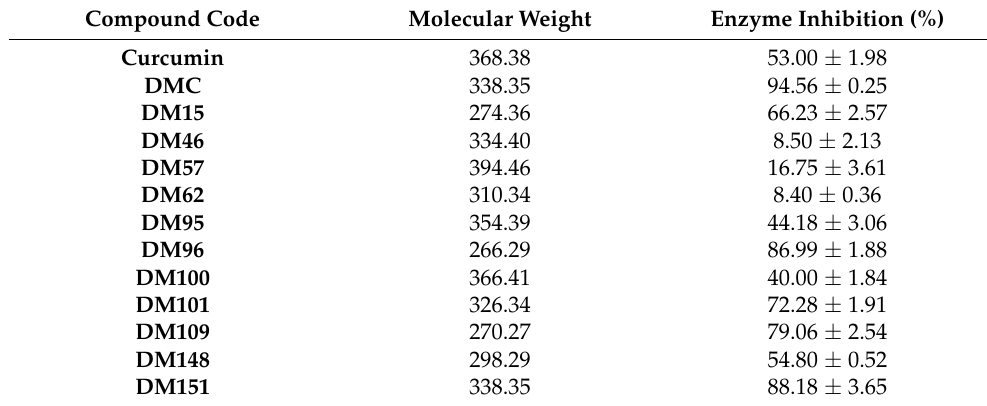
Table 1. Screening of the inhibition potency of the curcuminoids (curcumin and DMC) and the curcumin analogues against hGSTP1-1